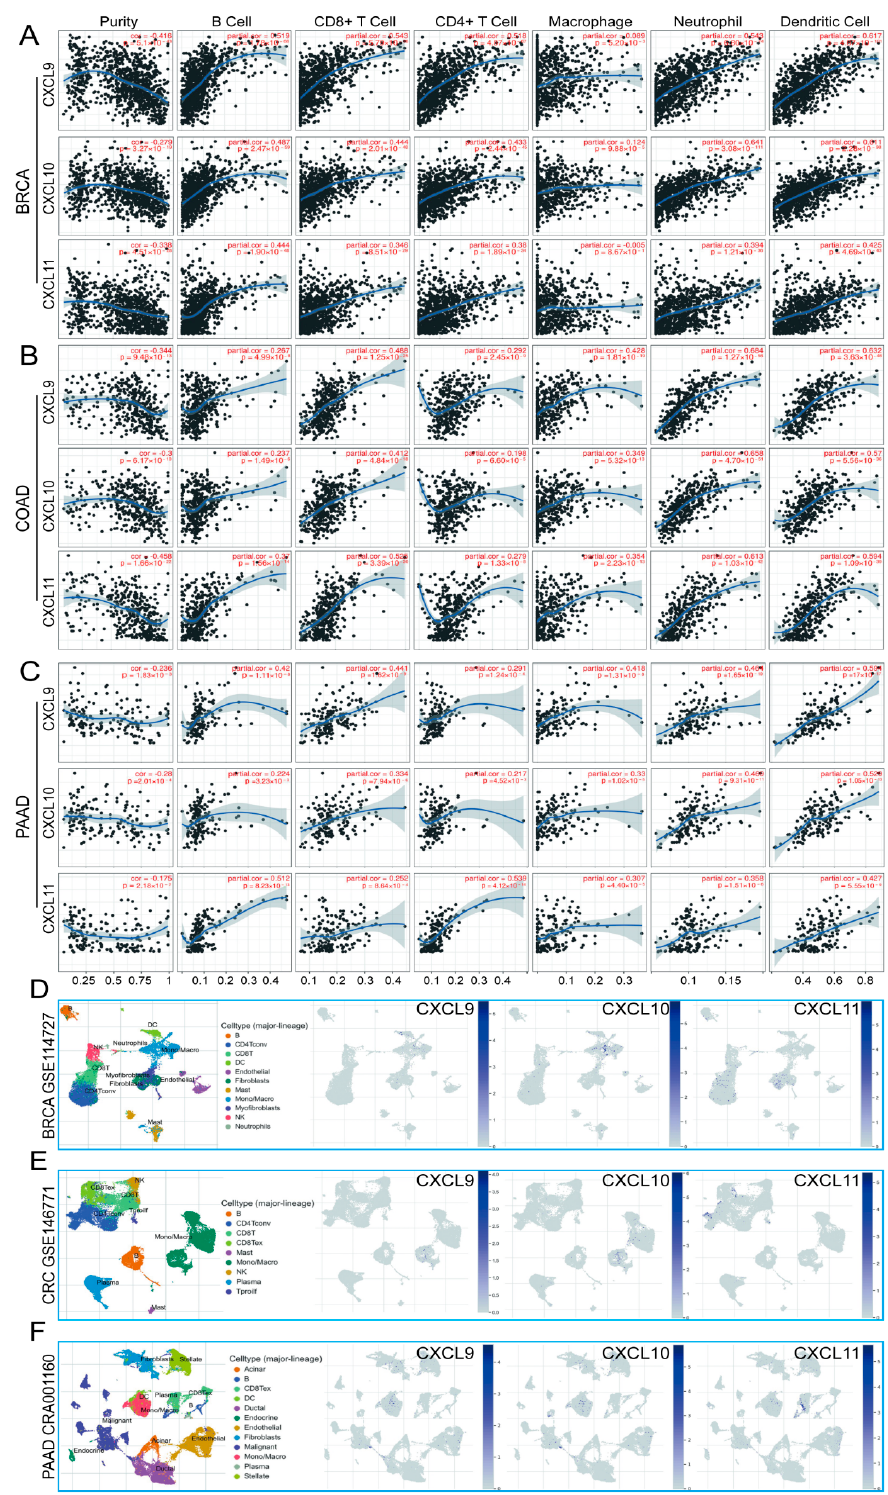
Figure 16. Correlation and distribution of differentially expressed CXCs and immune cell infiltration in BRCA, COAD, and PDAC (TIMER and TISCH). The association between the expression of CXCL9, 10, and 13 and the abundance of tumor-infiltrating immune cells in BRCA ( A , D ), COAD ( B , E ), and PDAC ( C , F ).